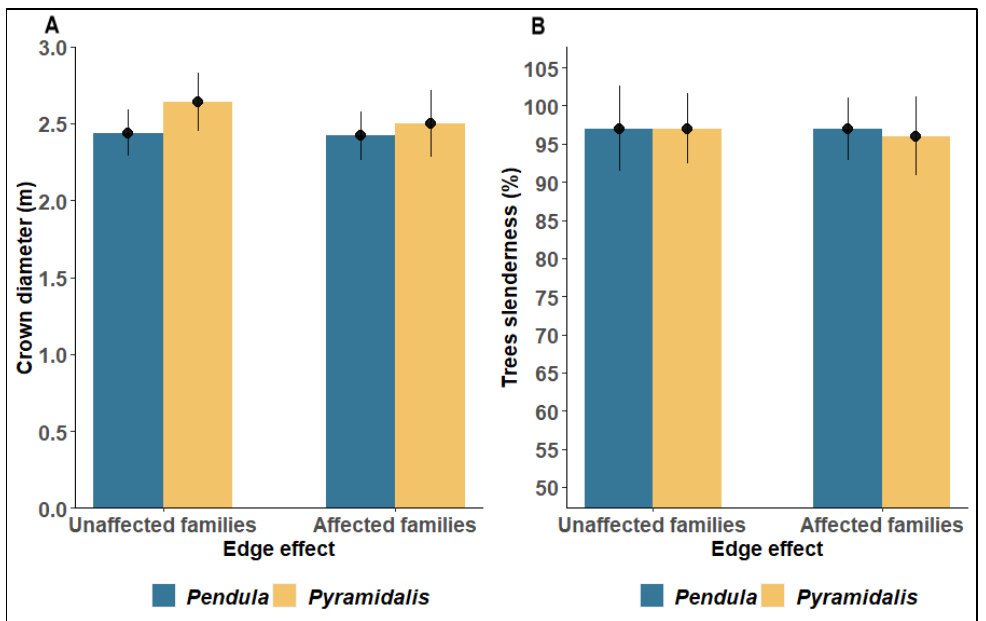
Figure 8. Variation in the stability traits: crown diameter ( A ) and tree slenderness ( B ) by the edge effect. The black vertical lines represent the standard deviation.